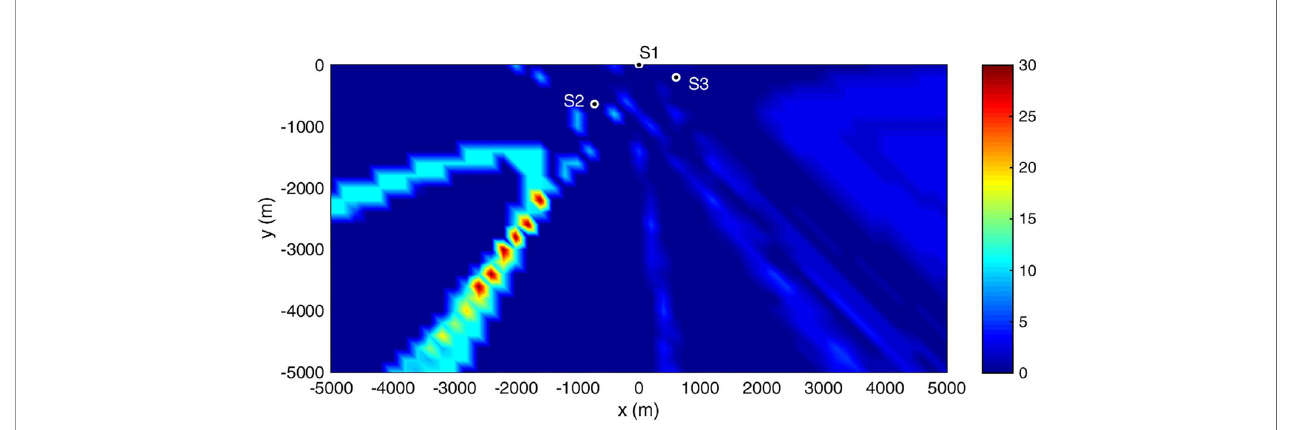
FIGURE 8 | Initial search for source location in the horizontal based on associations between paired arrivals at the different hydrophones, those shown in Figure 7D . The three black dots indicate the mooring locations and the color represents the association count as a function of source